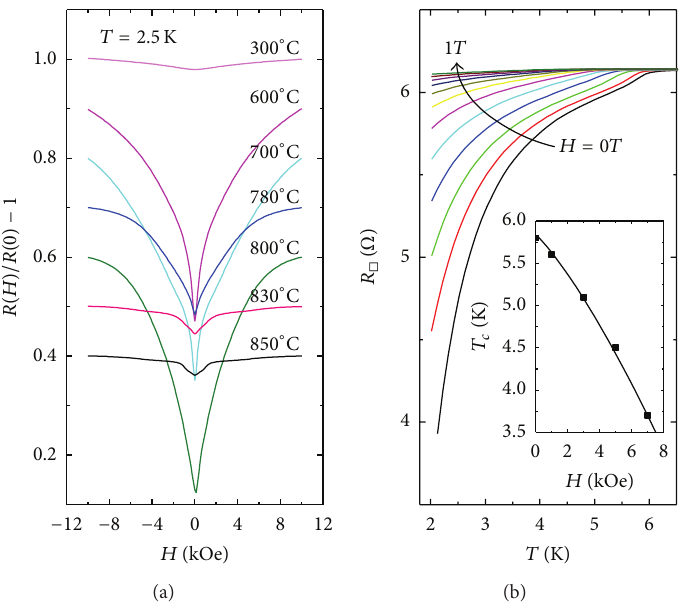
Figure 3: (a) The 𝐻 dependence of normalized magnetic resistance (𝑅(𝐻)/𝑅(0) − 1) measured at 𝑇 = 2.5 K for the samples annealed at temperature ranging from 300 ∘ C to 850 ∘ C. (b) 𝑇 dependence of the sheet resistance 𝑅 ◻ at various magnetic fields 𝐻 applied perpendicular to the surface for the samples annealed at 800 ∘ C. The inset shows the field-temperature ( 𝐻 − 𝑇 ) phase